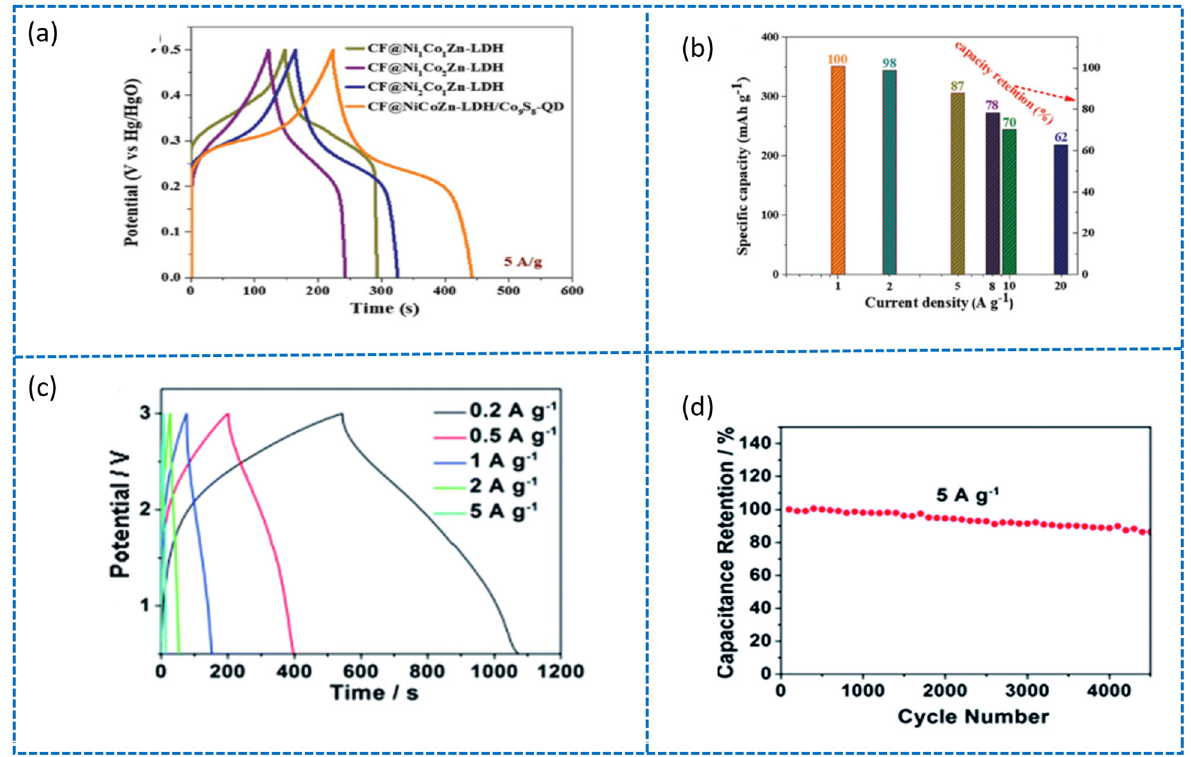
Figure 12: ( a ) Galvanostatic charge – discharge curves of NixCo 3 – x Zn - LDH and CF@NiCoZn - LDH/Co 9 S 8 - QDs ( current density of 5 A g − 1 ) . ( b ) The speci fi c capacity and capacity retention rate of CF@NiCoZn - LDH/Co - QDs ( current densities of 1 – 20 A g − 1 ) [ 118 ] . ( c ) AC/NQDs - NC 9 S 8 HSC charge – discharge pro fi les ( potential range of 0.5 – 3.0 V ) at various current densities ( 0.2 – 5 A g − 1 . ( d ) Cycle performance of NQDs - NC HSC for around 4,500 cycles ( current density of 5 A g − 1 ) [ 210 ]